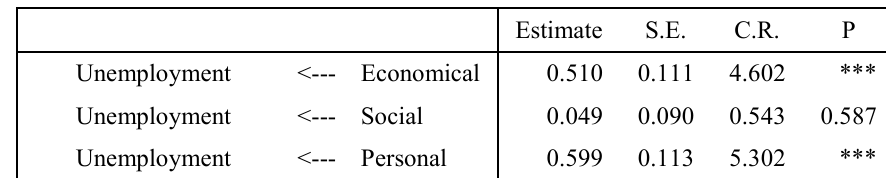
Table 3. Regression Weight for the Hypothesis Results